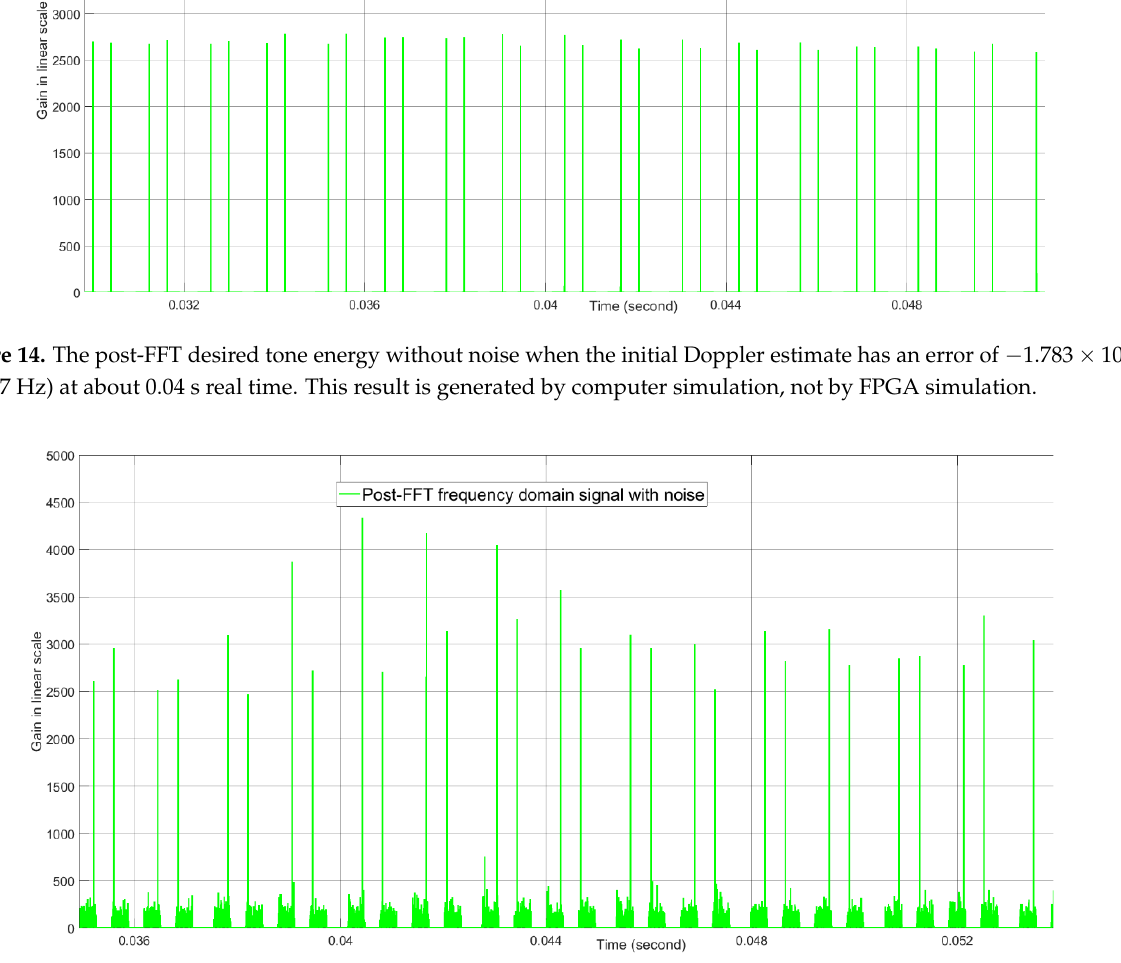
Figure 15. The post-FFT desired tone energy with noise when the initial Doppler estimate has an error of −1.783 × 10 − 5 (−55.7 Hz) at about 0.04 s real time. This result is generated by computer simulation, not by FPGA simulation.